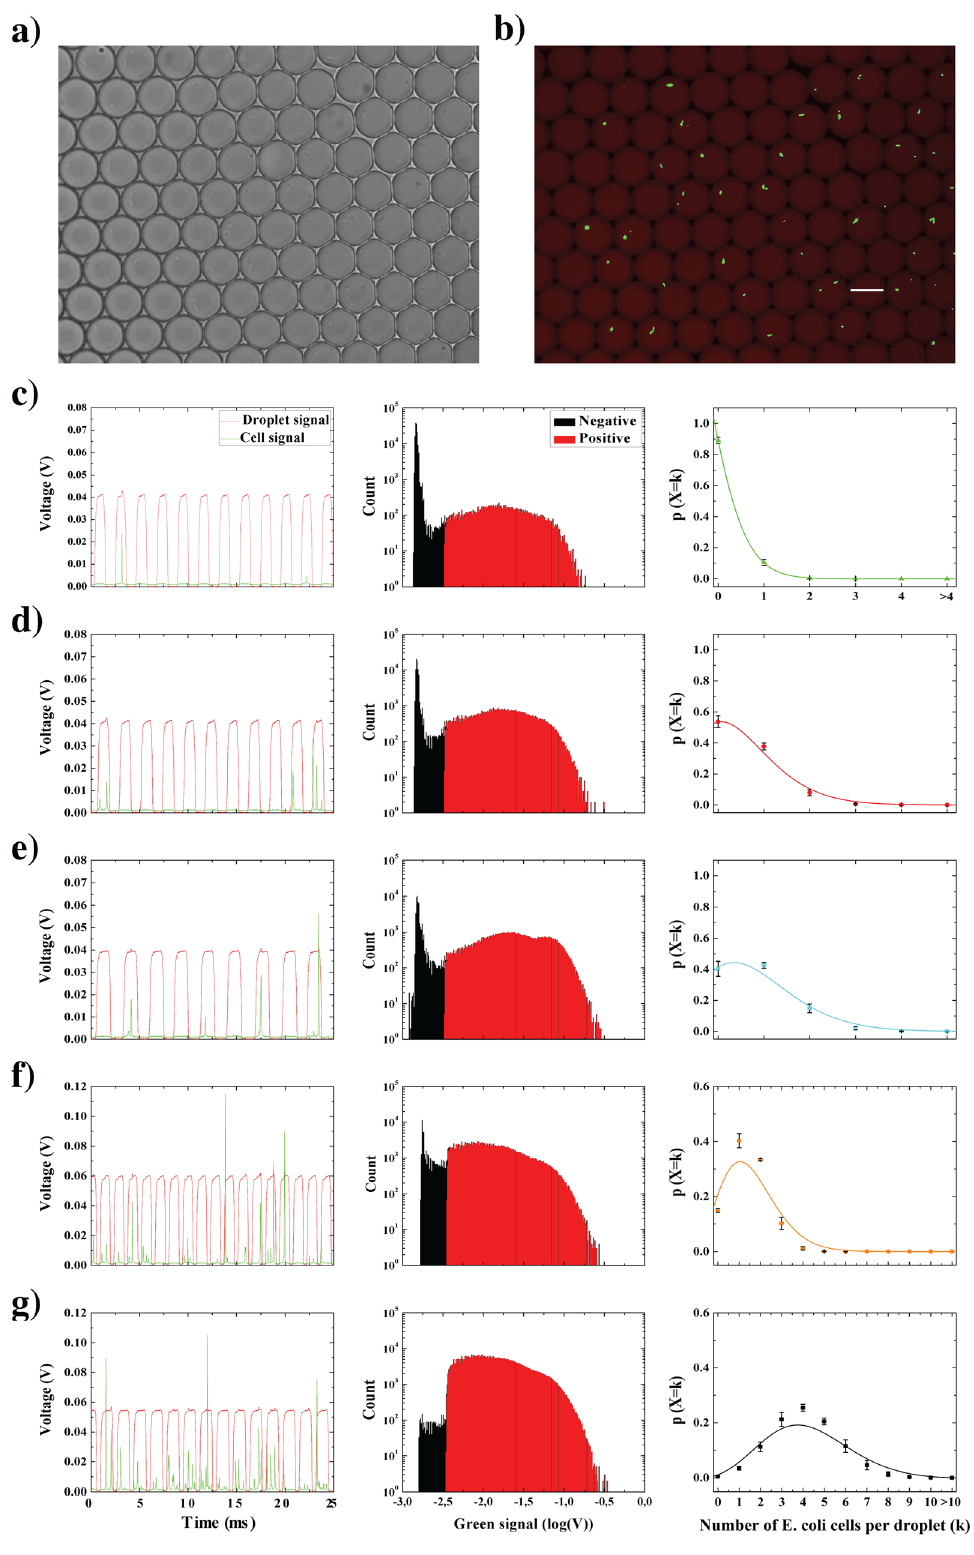
Figure 2. Counting of E. coli cells. Bright field image ( a ) and fluorescence image ( b ) of eGFP transformed E. coli cells encapsulated in droplets. The droplets were labeled by adding the soluble dye Sulforhodamine-B in the aqueous phase. Scale bar: 30 µ m. ( c – g ) From left to right: time sequences of red and green fluorescence signals, histograms of the green fluorescence signal depicting negative and positive cell count events, and cell distribution in droplets (mean ± s.d for n = 3 ( c – e ) and n = 2 ( f , g )); Poisson fit is plotted as a straight line). ( c ) Cell density was adjusted to 2 × 10 6 cells/mL such that expected theoretical cell to droplet